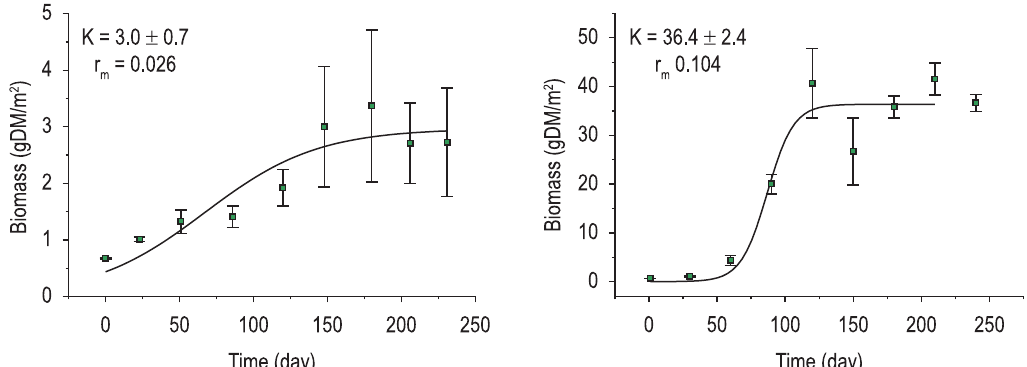
Figure 2. Growth curves of Salvinia molesta biomass (points = means; bars = standard deviations) in the non-impacted reservoir (NIR) and the effluent-impacted reservoir (IR). K = support capacity, r graphs use different scales.